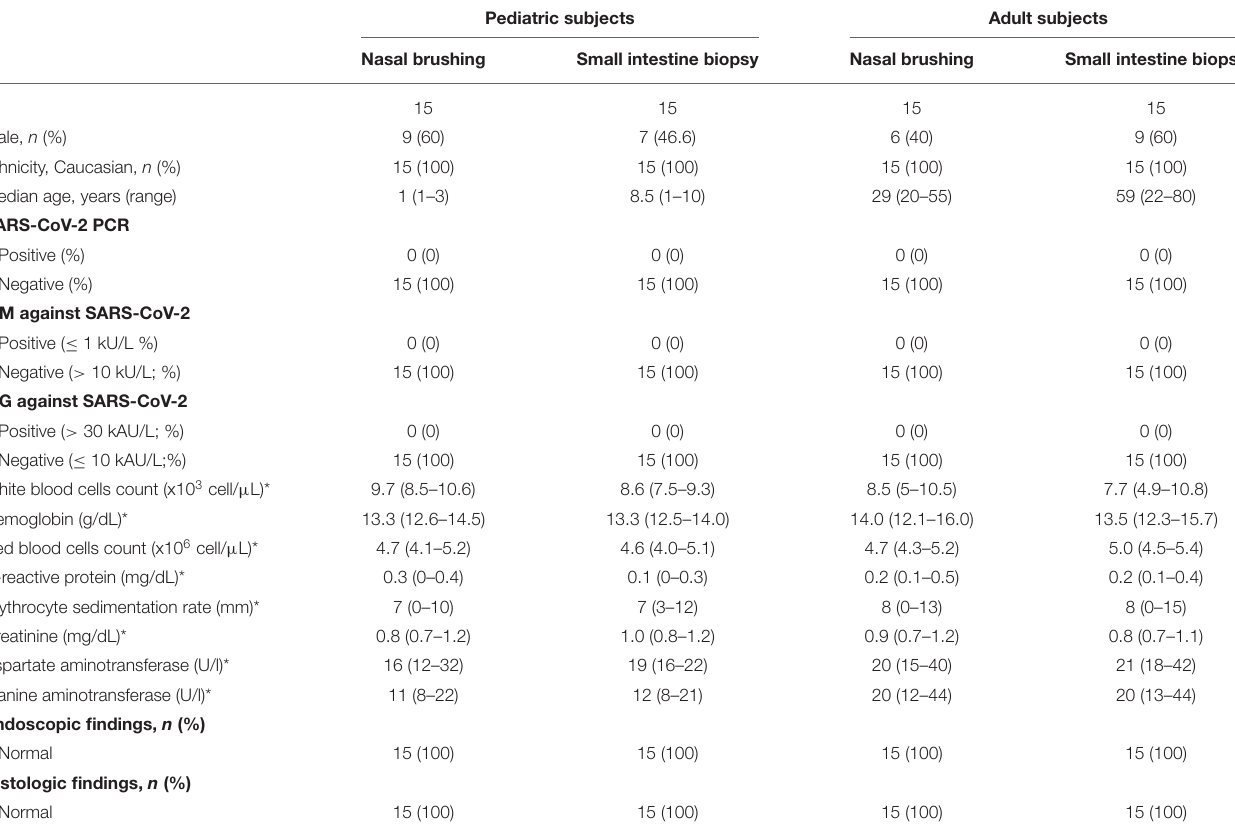
TABLE 2 | Main demographic and clinical features of the study